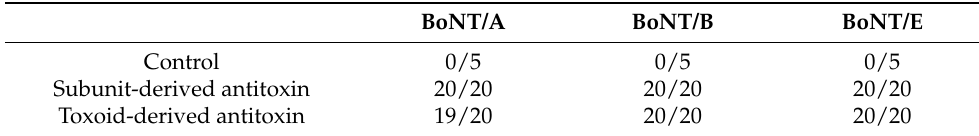
Table 1. Postexposure efficacy of subunit- and toxoid-derived antitoxin preparations in guinea pigs (survivals/number of animals in